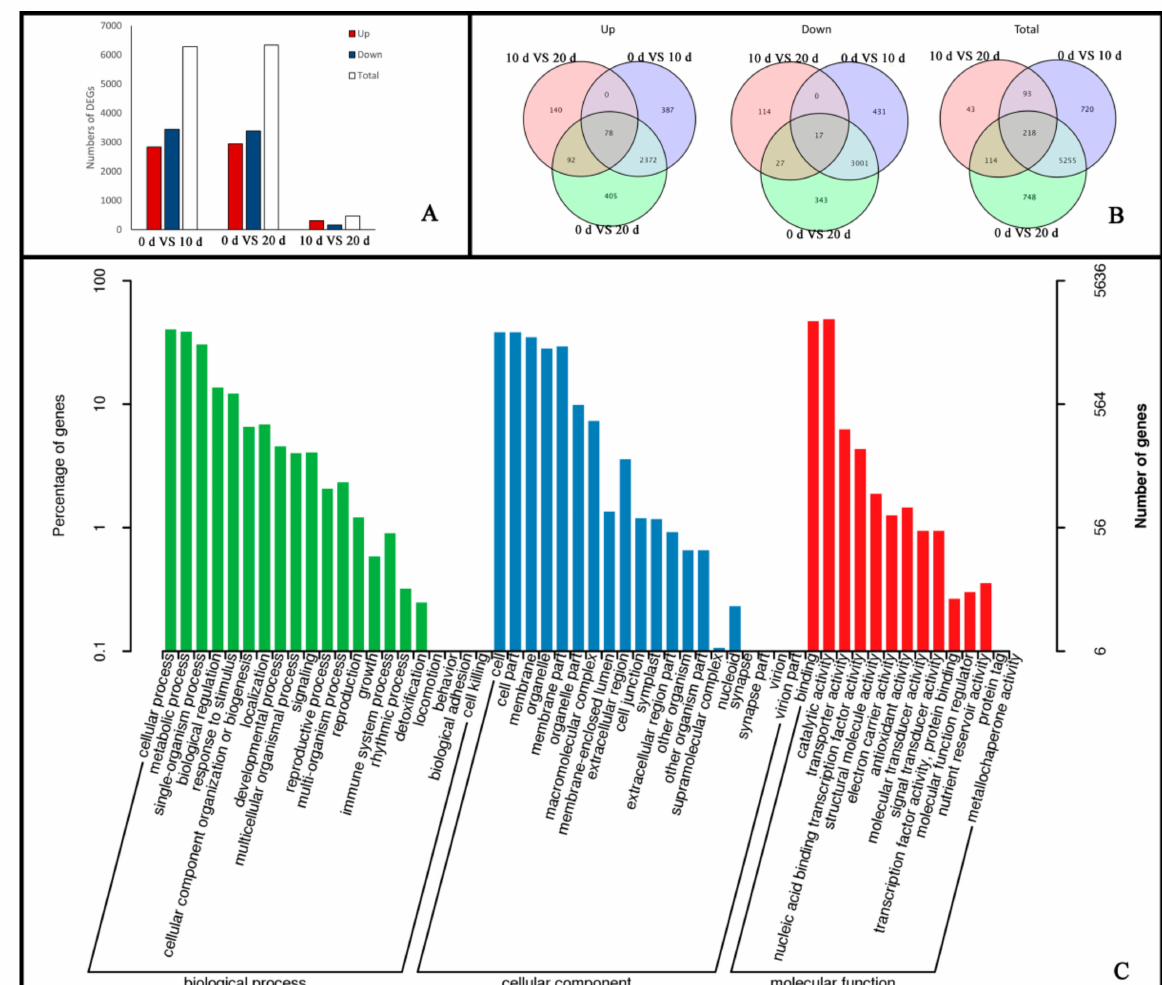
Figure 2. ( A ) Functional annotation and classification of genes related to embryogenic callus induction. Numbers of up- and down-regulated DEGs in different stages of embryogenic callus induction; ( B ) Venn diagram of annotated transcripts in multiple databases; ( C ) GO classification of DEGs in embryogenic callus